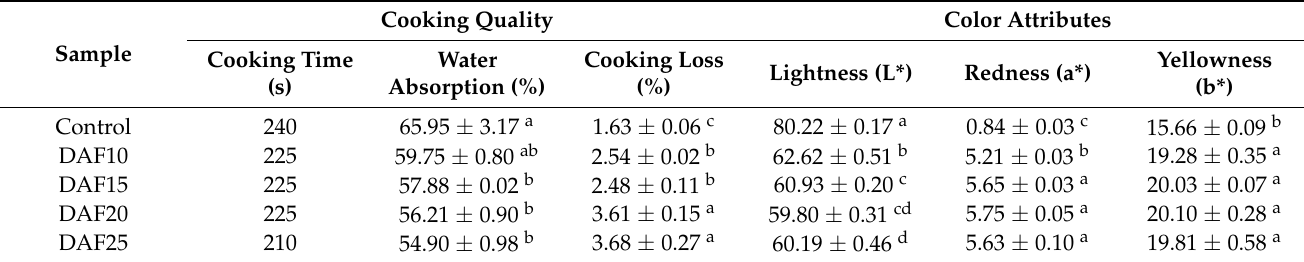
Table 4. Cooking quality and color attributes of wheat noodles with different substitution levels a,b .